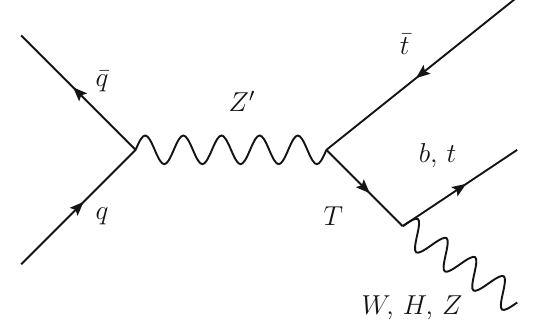
Fig. 1 Leading order Feynman diagram for the production of a spin- 1 resonance Z (cid:3) and its decay, along with the possible decays of the vector-like quark